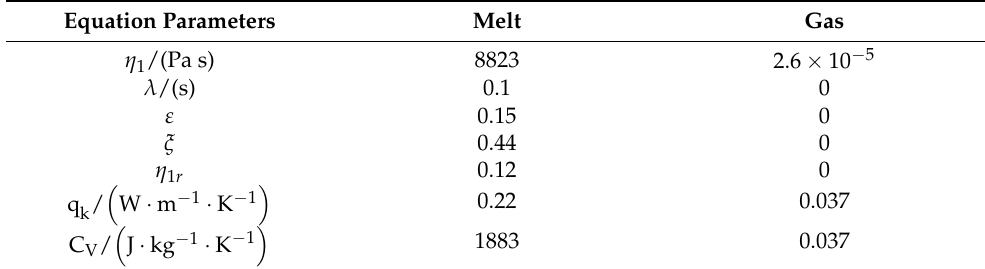
Table 1. Numerical simulation parameters of the melt and